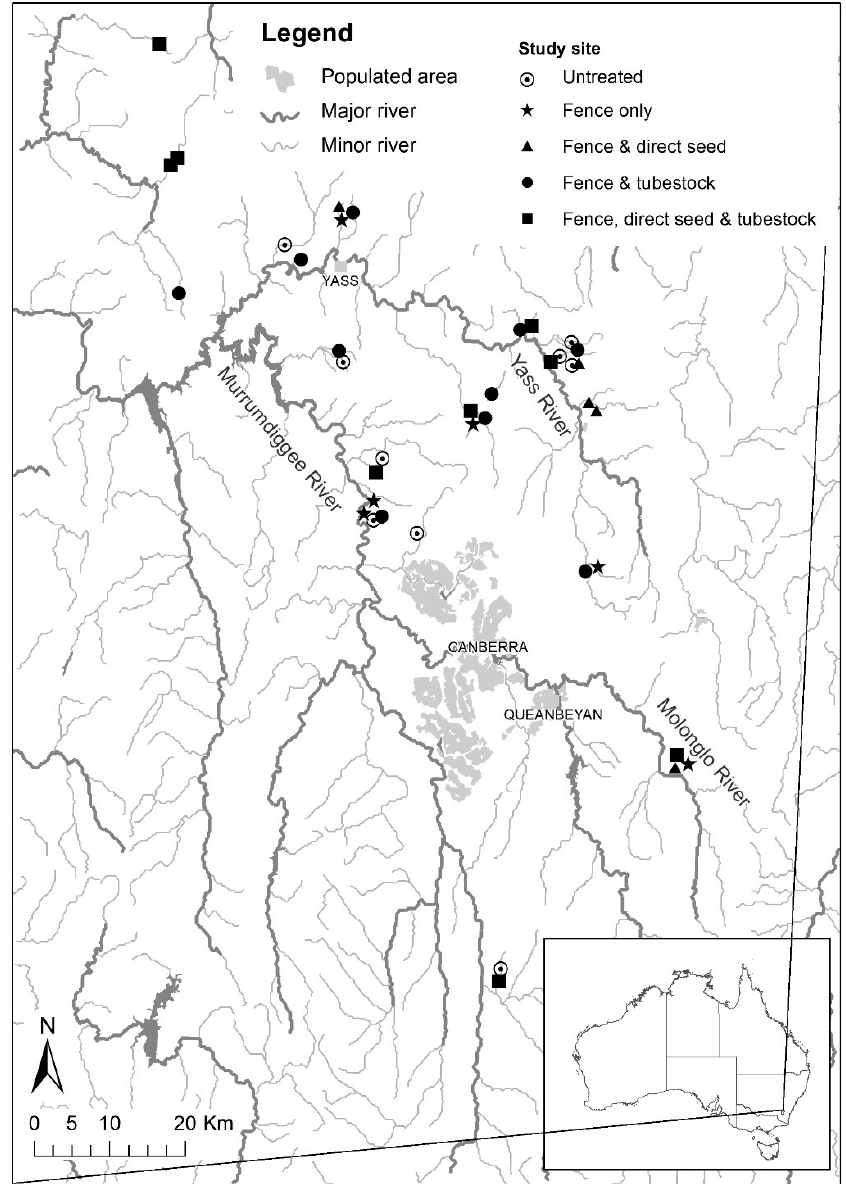
Figure 1. The location of the 29 restoration sites from the Bidgee Banks Restoration Program (BBRP) and nine untreated sites in the Upper Murrumbidgee River Catchment. Sites are classified by restoration method.